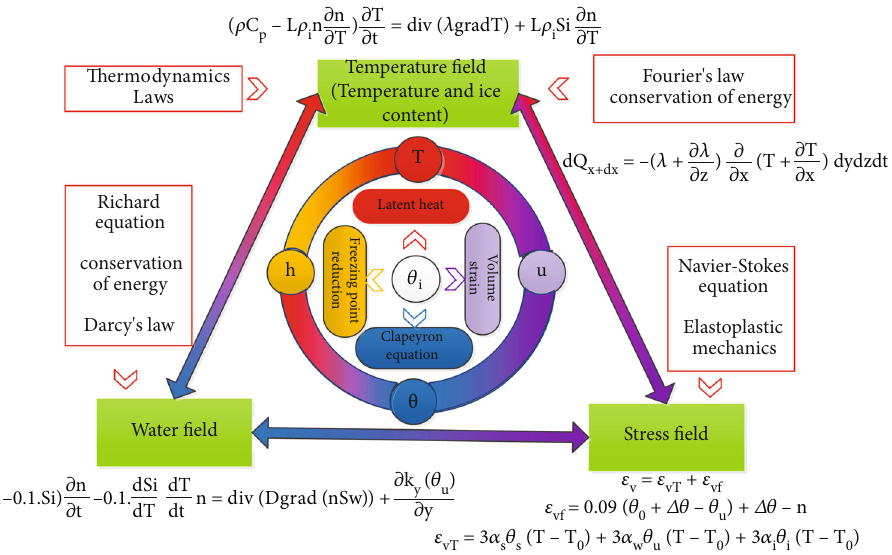
Figure 2: THM coupling diagram of frozen